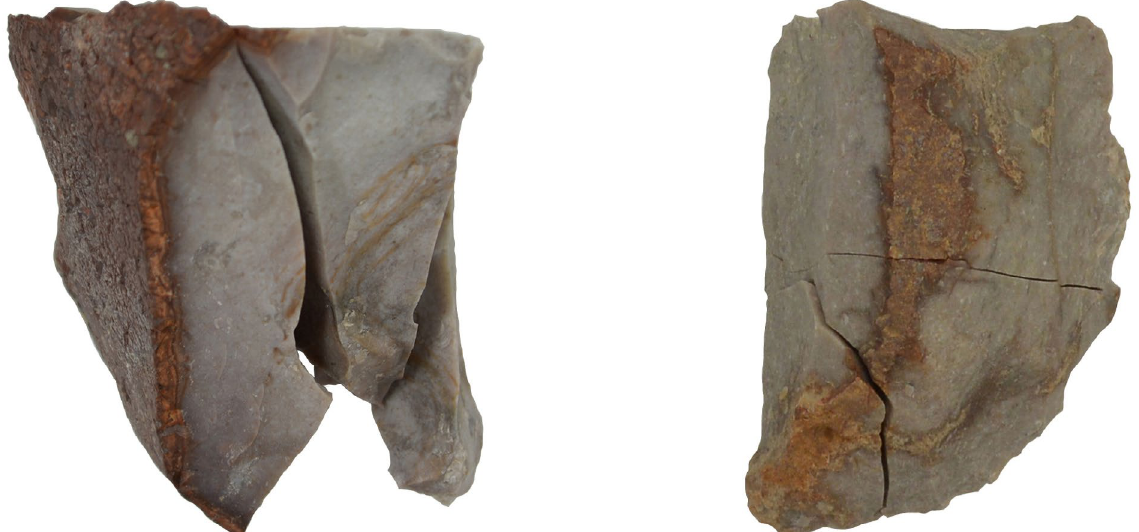
Figure 7. Flint samples broken by overheating thermal damage at 450